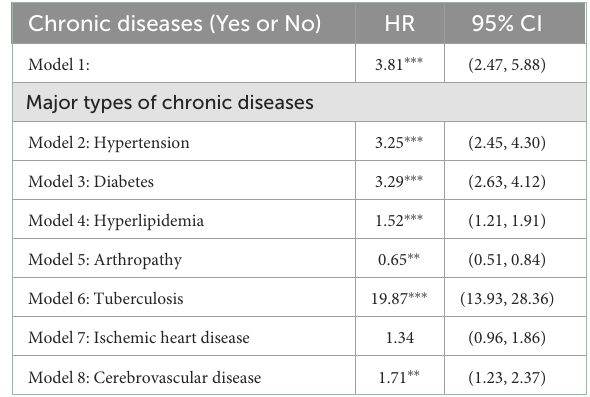
TABLE 5 Additional analyses of parametric survival (Weibull) regression of newly developed disability.